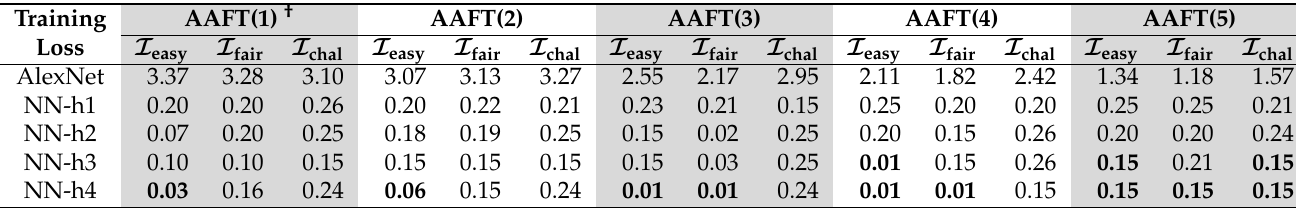
Table 4. The mean of training loss for AlexNet and neural networks (NNs). h1 through h4 represent the number of hidden nodes in a hidden layer.